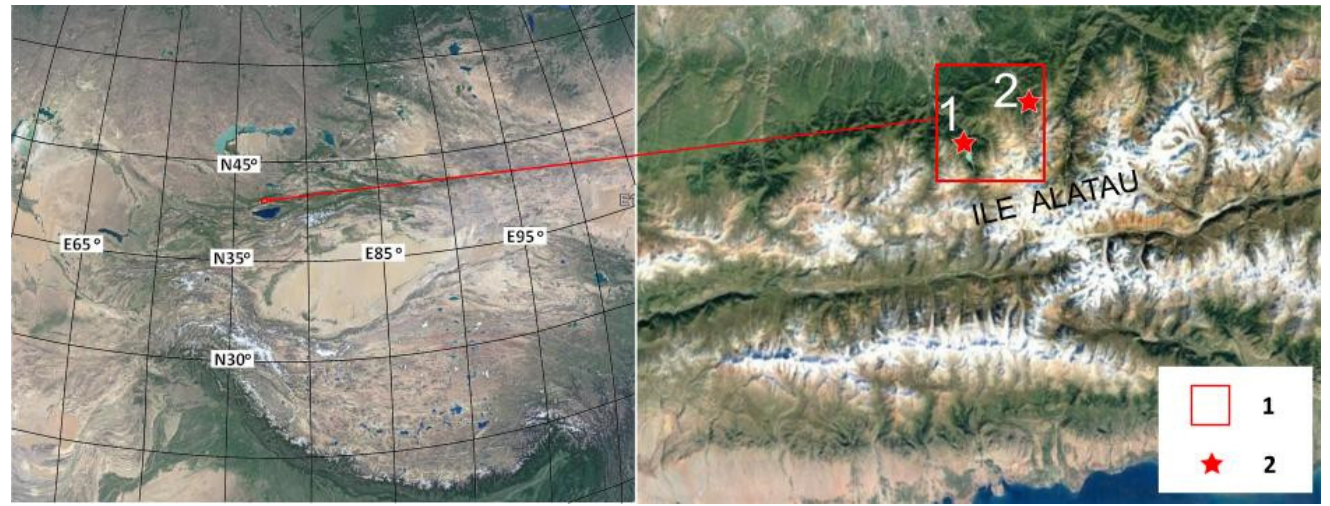
Figure 1. The location of the study area. 1 —Study area boundaries; 2 —Weather and avalanche ob- servation stations: 1—Big Almaty Lake, 2—Shymbulak. observation stations: 1—Big Almaty Lake,